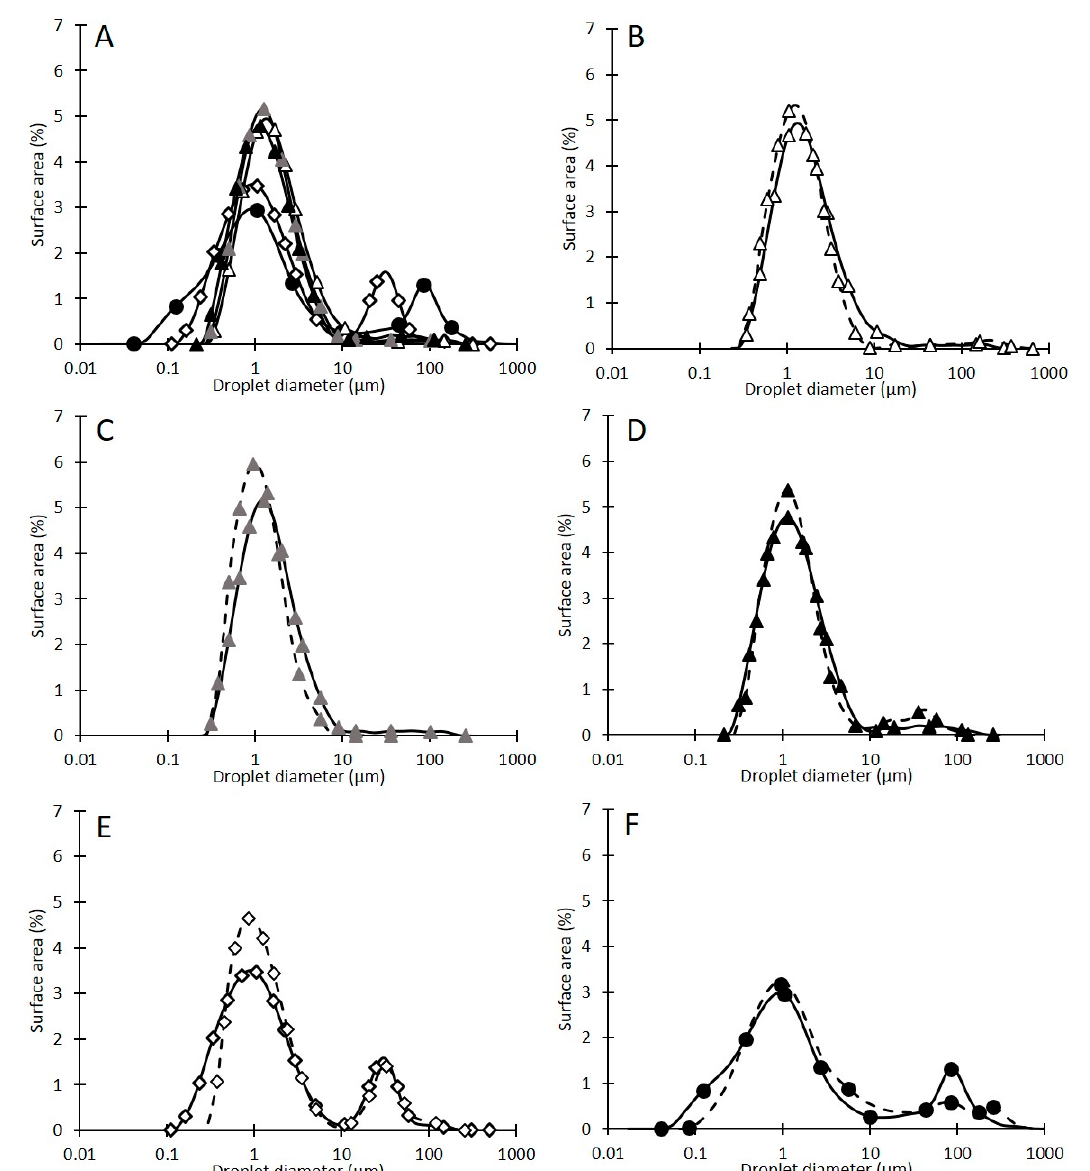
Figure 6. Surface area (%) distributions of the droplet size in the produced o/w emulsions on day one ( A ) from colloidal particle dispersions produced by antisolvent precipitation of lignin in an ethanol solution and water at concentrations of 2 ( (cid:52) ) ( B ), 5 ( (cid:78) ) ( C ) and 10 mg HEE/mL ethanol ( (cid:78) ) ( D ) via magnetic stirring, 2 mg HEE/mL via a syringe pump method ( ¯ ) ( E ) and 2 mg LR-HEE/mL ethanol ( • ) ( F ) via magnetic stirring. Individual graphs represent oil droplet diameters following 1 day (solid line) and 7 days (dashed line) post production for colloidal particle dispersions.